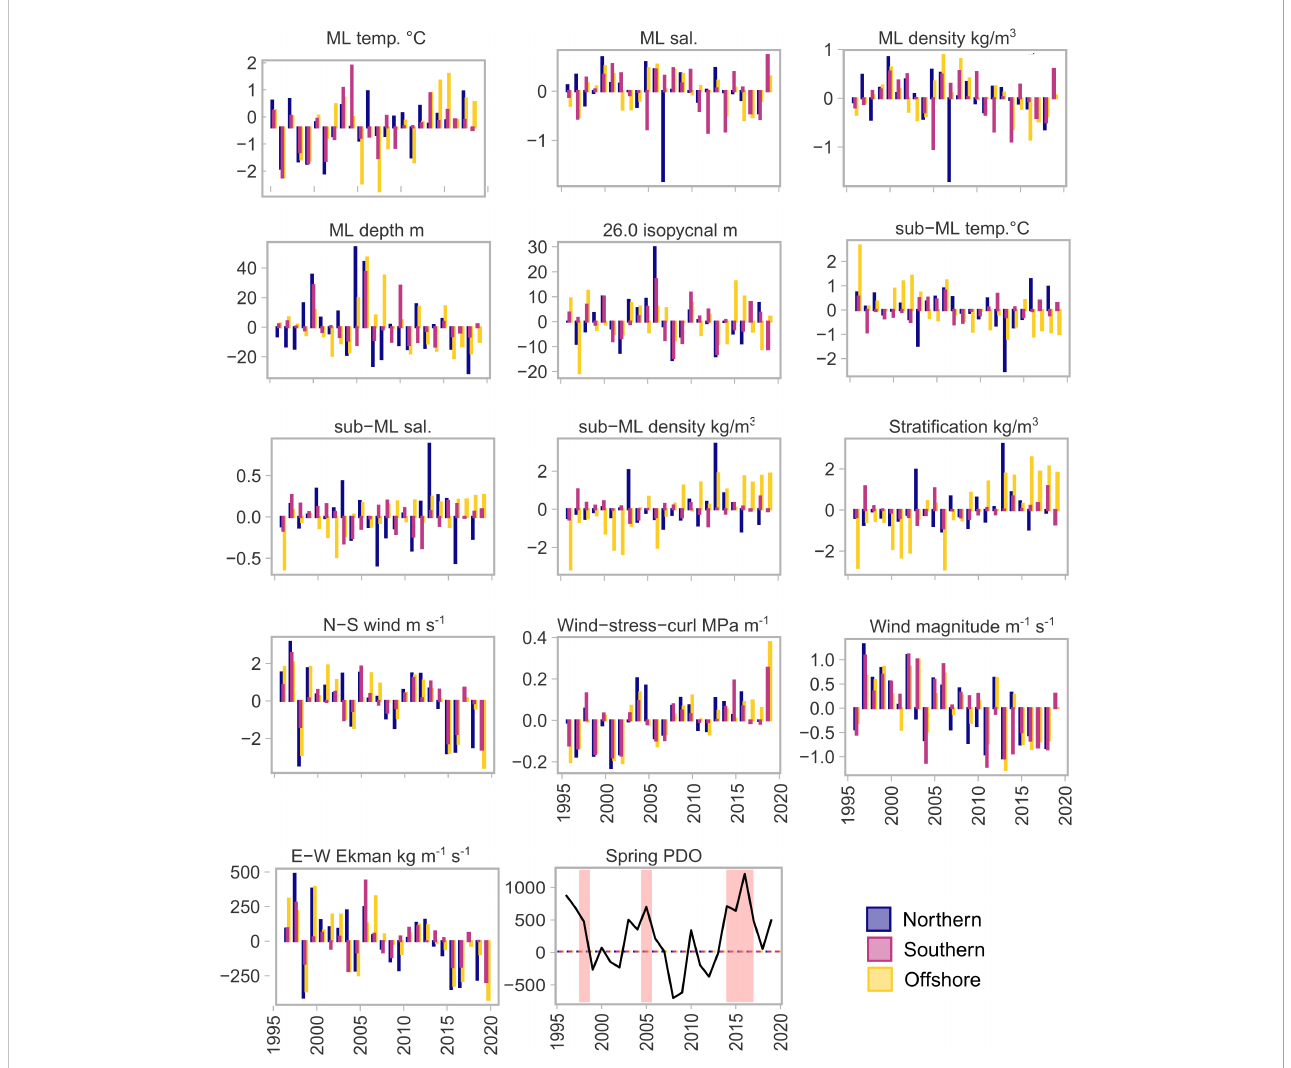
FIGURE 2 Annual mean anomaly (across stations) for each bioregion, of all variables considered in multivariate and spatiotemporal analysis of ocean-climate conditions. Spring PDO shows the PDO phase during April, May and June of each year - red highlighted regions represent ‘ warm ’ periods that are mentioned in the text; the 1997 El Niño, the 2005 ‘ warm ’ event, and the 2014-2016 MHW event. Anomalies were calculated based on the time-series analysed: 1996-2019. ML, mixed layer; temp., temperature °C; sal., salinity; N-S, north-south; E-W, east-west. See Figure 1 for bioregion